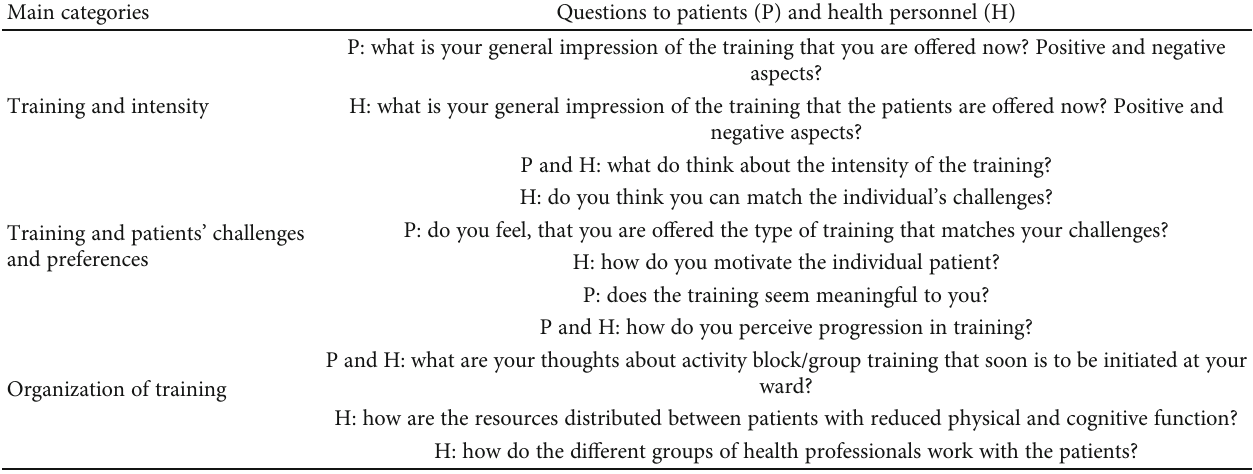
Table 2: Interview guide May 2019.